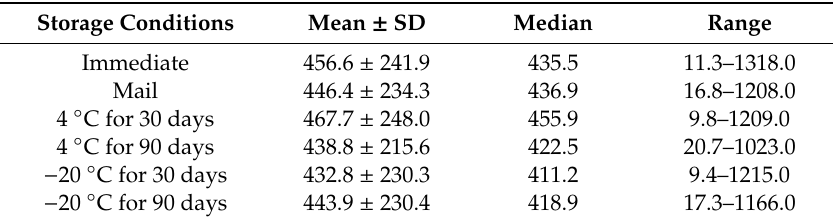
Table 1. Cotinine data description (in ng / mL) for the 182 samples treated according to the di ff erent storage